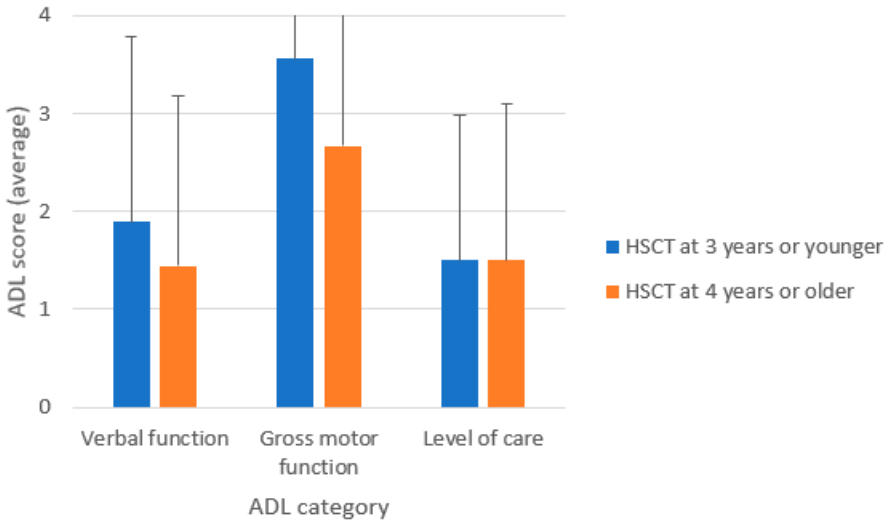
Figure 4. Age at HSCT and ADL scores for severe phenotype MPS II patients.